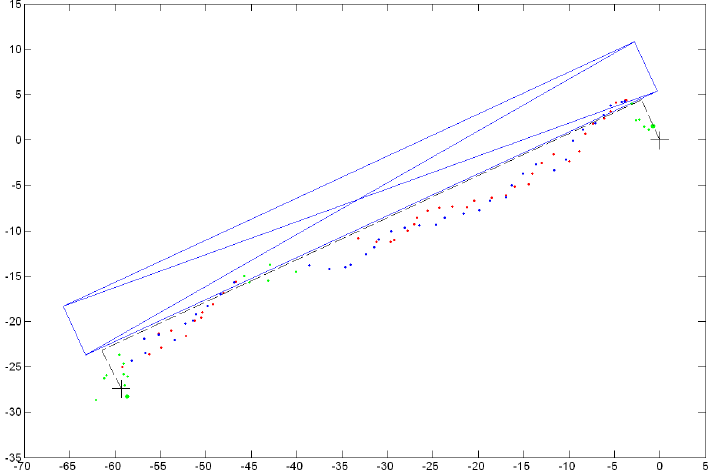
Figure 9 . Conditional DGPS inenvironment (e): (●) cDGPS positions; (●) custom positioning procedure with C1&D1; (●) recalculated positions. Units are in meters.